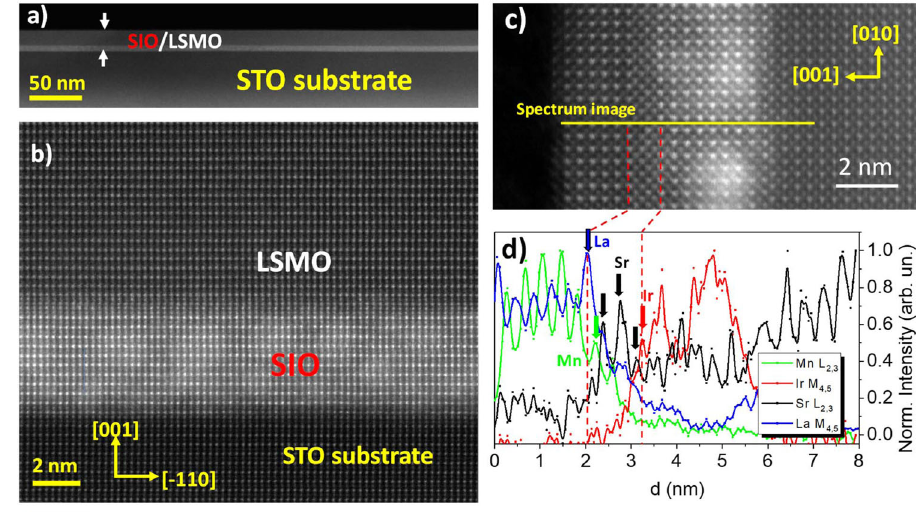
Fig. 1 Structure and chemistry of the interfaces. a Low magni fi cation HAADF image of an LSMO (15 nm)/SIO (4.4 nm) sample. b High-resolution image of the [110] [001] SIO/LSMO interface. c High-resolution image of the [010] [001] LSMO (2.4 nm)/SIO (3 nm) interface and corresponding normalized intensity pro fi le of the Mn L 2,3 (green symbols), La M 4,5 (blue symbols), and Ir M 4,5 (red symbols) and Sr L 2,3 (black symbols), of an EELS line scan acquired across the LSMO/SIO/STO